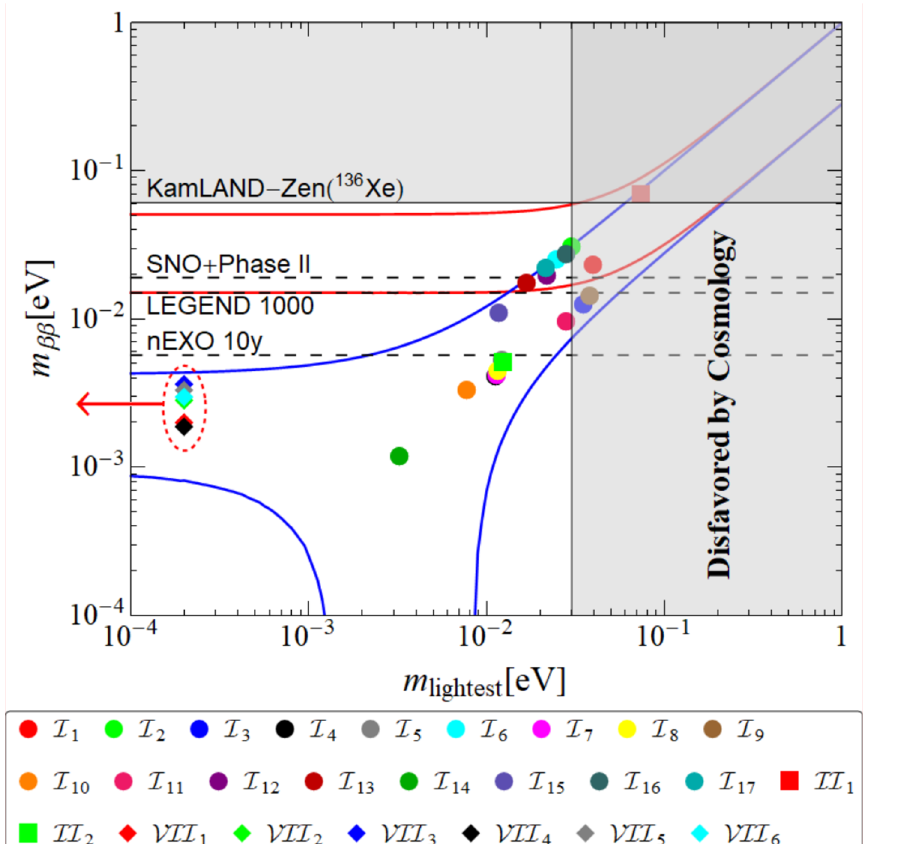
Figure 3 . The predictions for the effective mass of the neutrinoless double beta decay for the models of type I, type II and type VII. Notice that the lightest neutrino is massless for type VII models since only two right-handed neutrinos are introduced. The blue (red) lines denote the most general allowed regions for NO (IO) where the neutrino oscillation parameters are freely varied in their 3 σ regions [4]. The vertical grey exclusion band denotes the bound on the lightest neutrino mass coming from the cosmological data Σ 0 . 120 eV at 95% confidence level obtained by i m i < the Planck collaboration [2]. The current experimental bound from KamLAND-Zen [75] and the estimated experimental sensitivities of future 0 νββ experiments are indicated by the horizontal